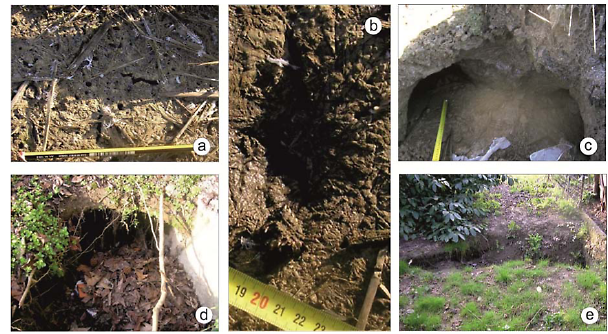
Fig. 11. Hypothesized evolutionary steps in sinkhole-like features formation: (a) little holes of water circulation along soil fractures; (b) partial hollow zone; (c) vault fall showing horizontal tunnels; (d) horizontal tunnels; (e)